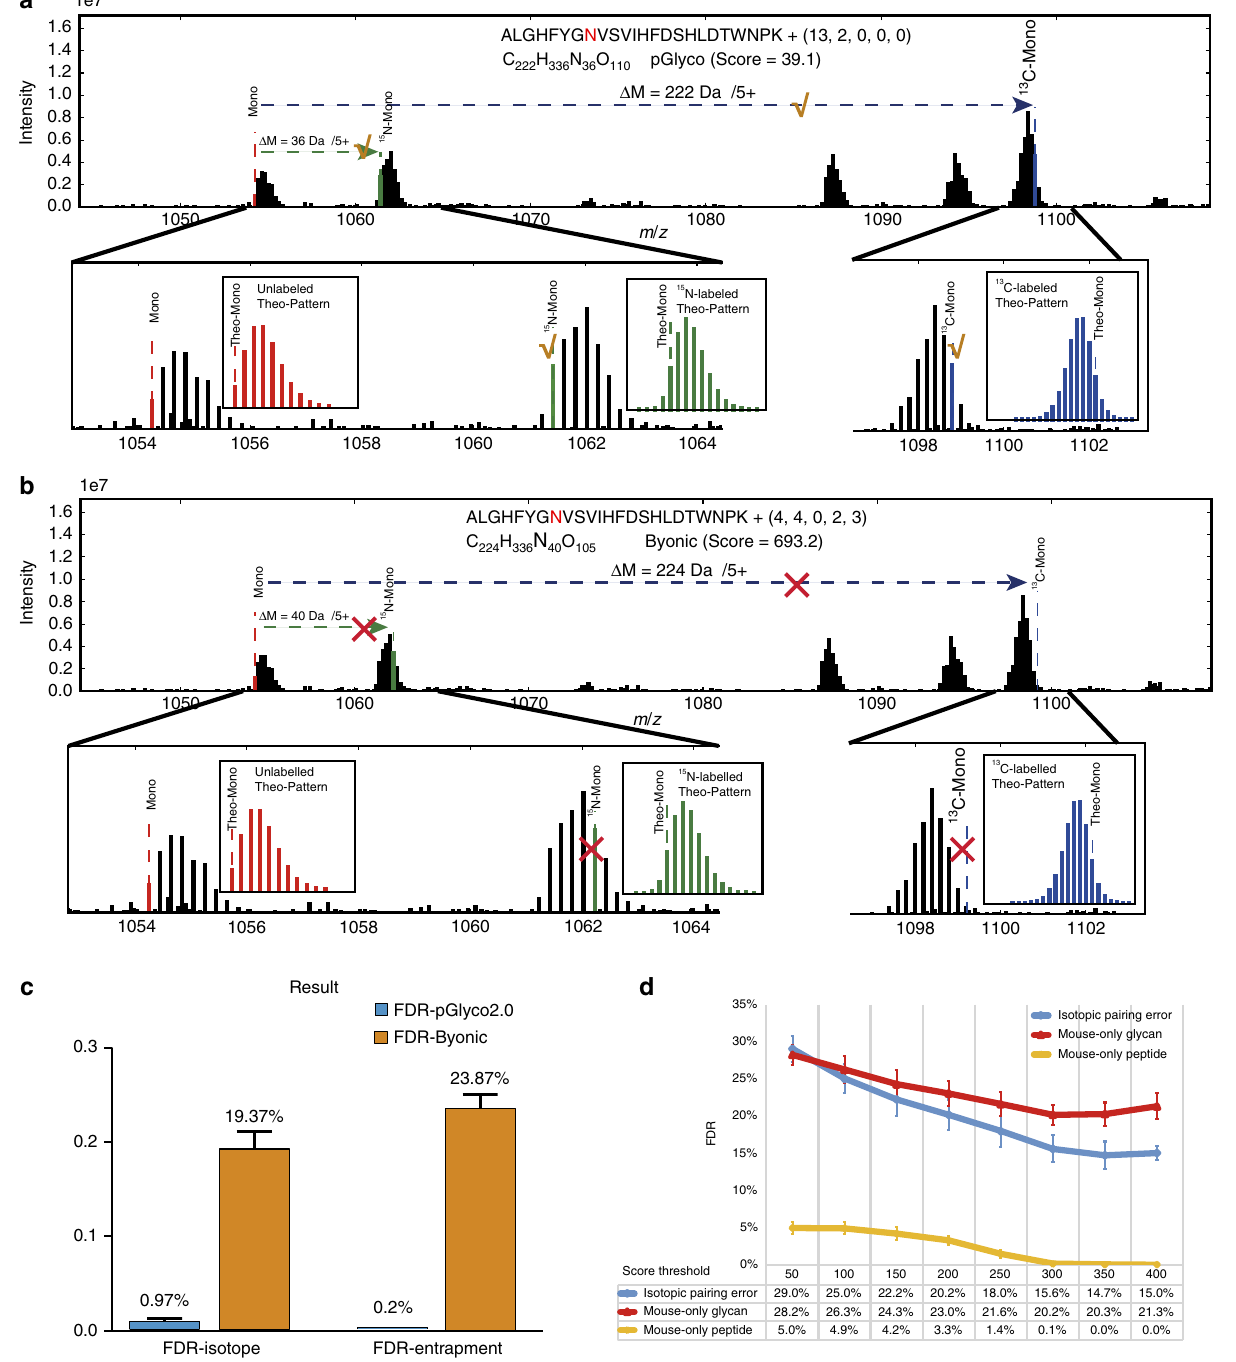
Fig. 5 FDR validation results. a , b Isotopic peak pairing analysis of different glycopeptide identi fi cations by pGlyco 2.0 and Byonic for the same spectrum. Both 15 N- and 13 C-labeled precursors agreed with the glycopeptides reported by pGlyco 2.0 a . Analysis of the heavily labeled precursor reported by Byonic in MS1. Neither the 15 N- nor 13 C-labeled precursors agreed with the glycopeptides reported by Byonic b . c FDRs of pGlyco 2.0 and Byonic for three LC-MS/ MS runs. d FDR analysis of the glycopeptide identi fi cations reported by Byonic under different score